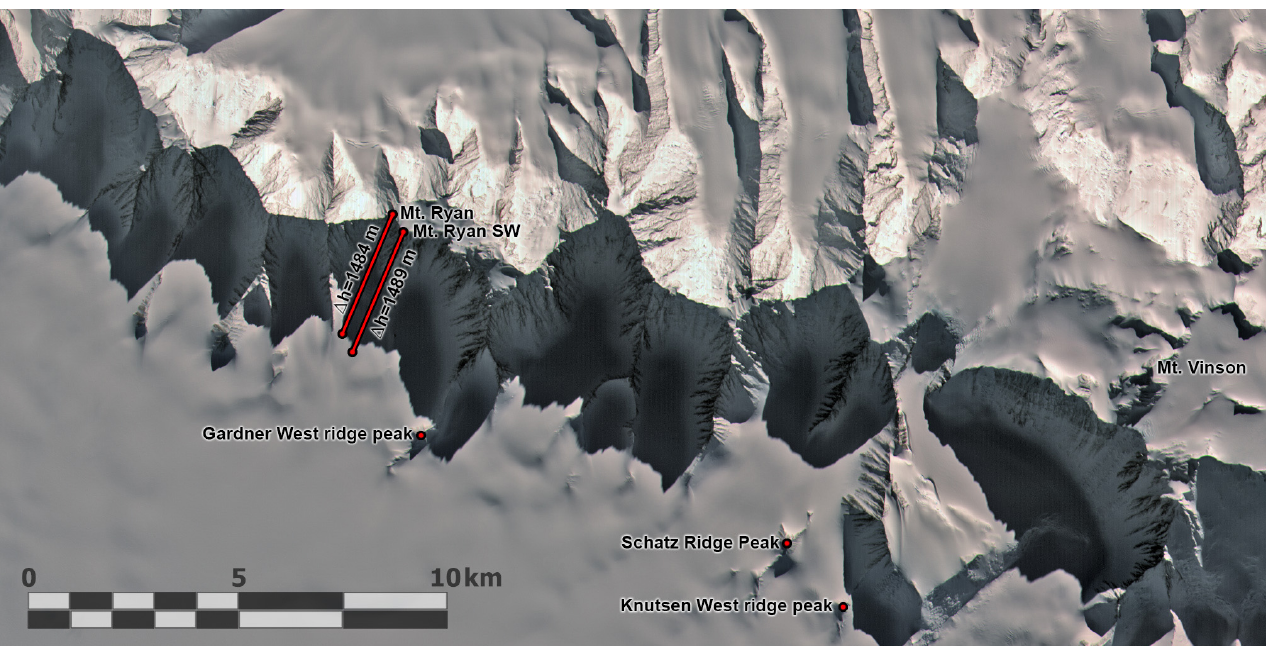
Figure 13. ASTER scene from 9 January 2003 used for the Sentinel Range validation site. Solar elevation for this scene was 24.5°, and the calculated refraction was 1.7 arcminutes. Red dots show all the features used as projectors in all four scenes used at this site. Red lines show shadows used for validation in this scene. Next to the red lines, the elevation differences between shadow and projector are shown. For reference, we also show the position of Mount Vinson, the highest mountain in